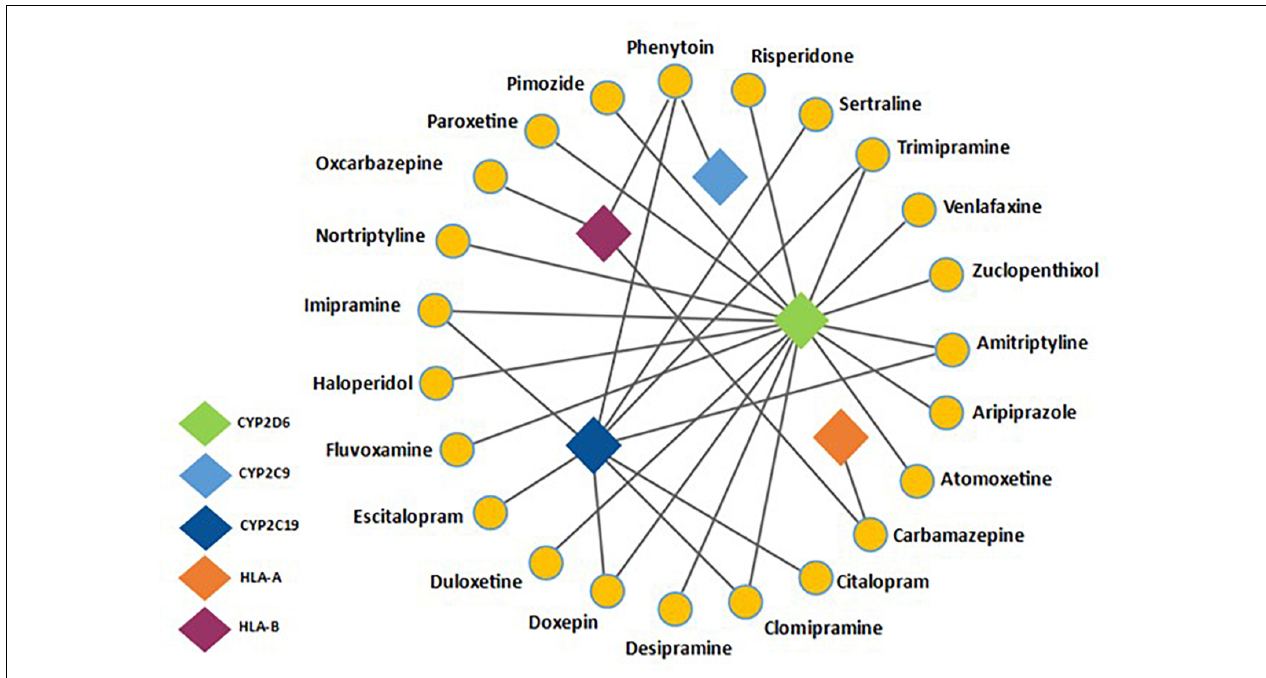
FIGURE 1 | Adapted from Bousman C. et al. (2019) and information presented on https://www.pharmgkb.org/- a network analysis detailing common psychotropic drugs with their associated pharmacogenes. CYP2D6 and CYP2C19 are common metabolic pathways for a range of antidepressants and antipsychotics. Also noted is the drug-gene interaction between HLA-B and Phenytoin/Carbamazepine, a well-documented pharmacogenetic